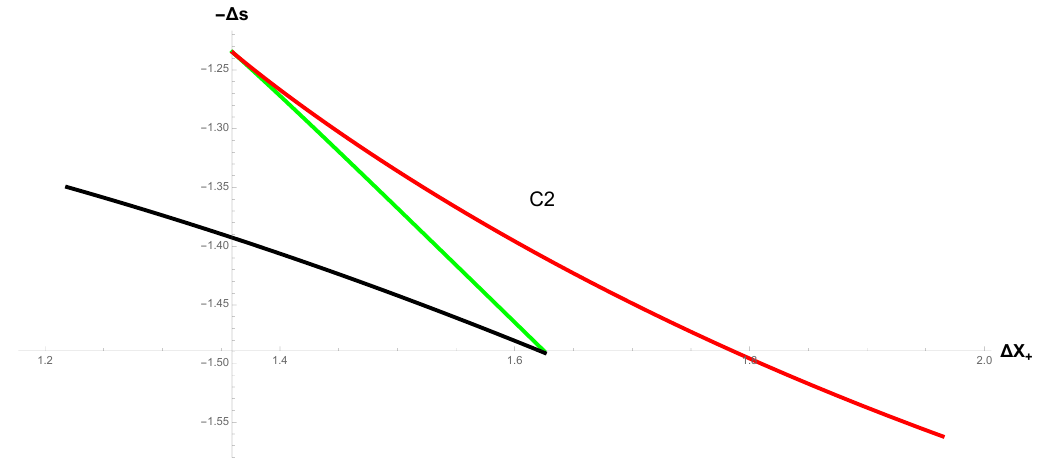
Figure 10 . Crossover of geodesic lengths with the thermal branch as a function of (cid:1) X + for M = 1 and u (cid:3) = 0 : 95. The geodesic touches the shell where the gray and green lines meet. However it crosses the shell before that when the red line crosses the gray one.